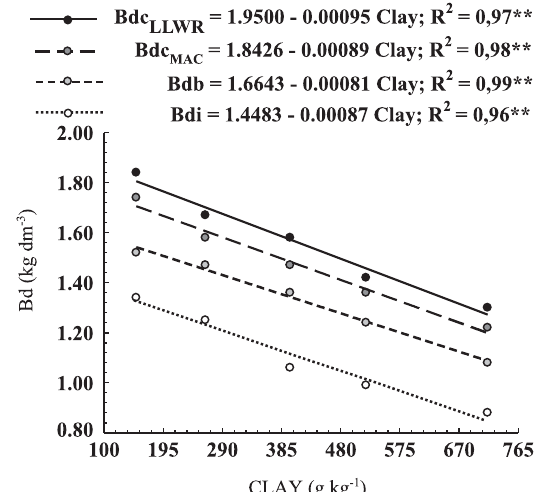
Figure 4. Initial bulk density (Bdi), beneficial density in terms of increase in soil water retention (Bdb), critical density for a reduction of macroporosity ), and critical density to 0.10 dm 3 dm -3 (Bdc MAC to plant growth and yield, based on the least limiting water range (Bdc ) and clay content LLWR of Latosols (L) in the county of Rio Verde,